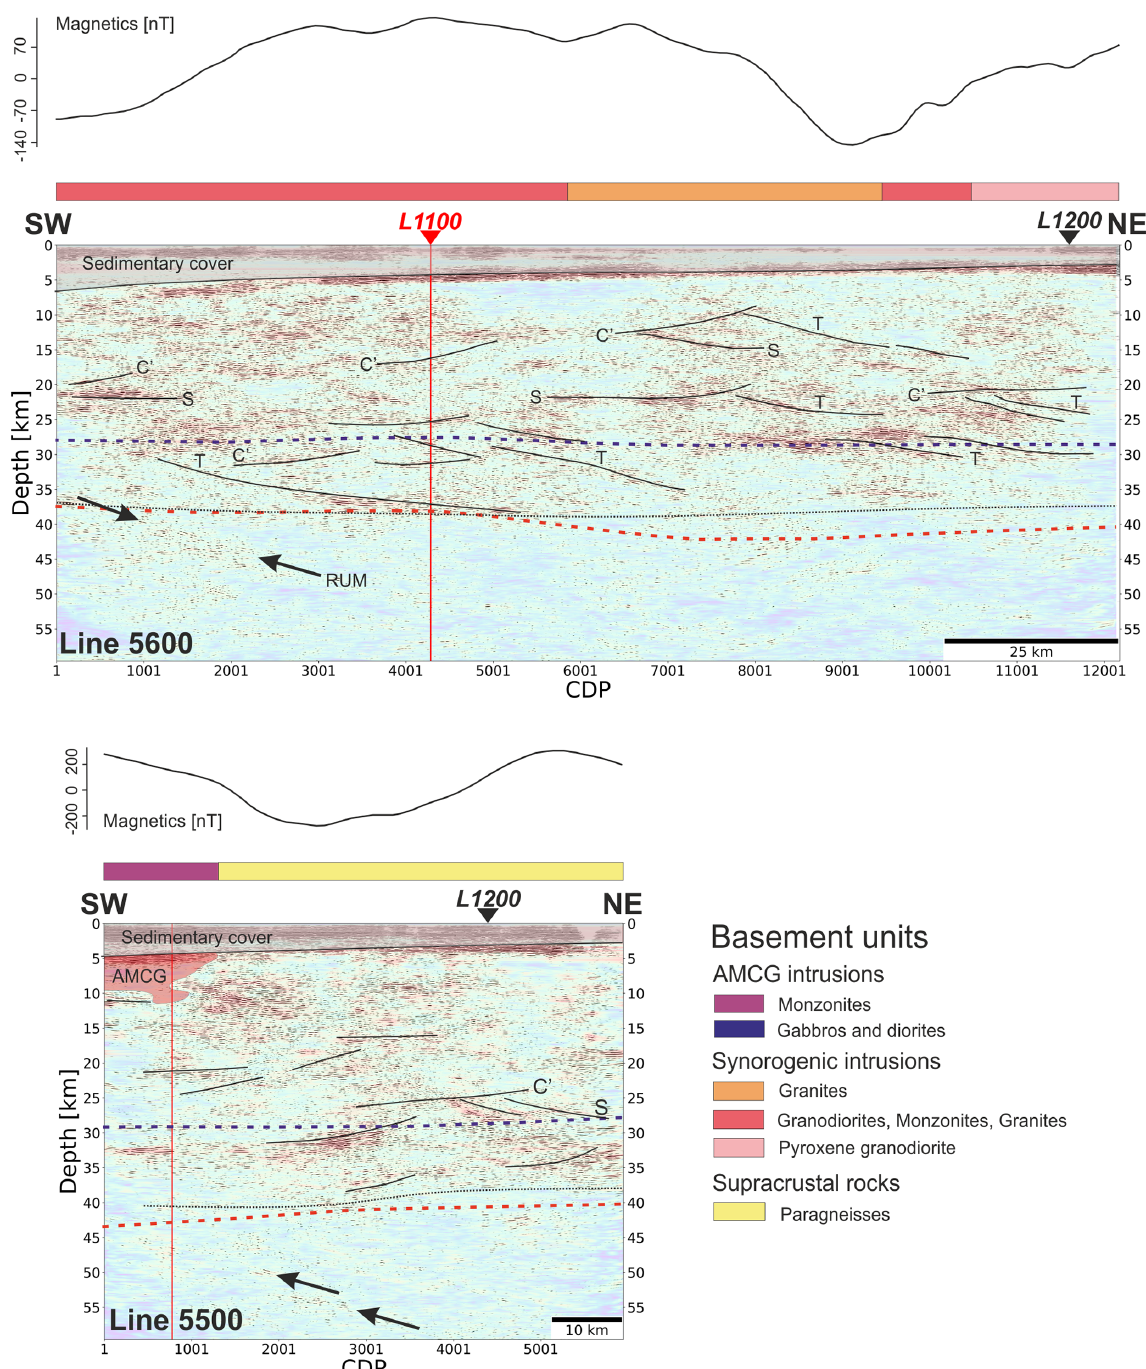
Figure 9. Final migrated depth-converted sections along PolandSPAN ™ profiles 5500 and 5600 with their tentative interpretation. Bars atop the section are colour-coded according to the crystalline basement lithologies following Krzemi´nska et al. (2017) (see Fig. 9 for a legend). The magnetic profile at the top is extracted from the magnetic anomaly map (Fig. 3). S – subhorizontal structural layering (Svekofennian orogenic fabric); T – ductile thrust shear zones; C (cid:48) – extensional shear zones.